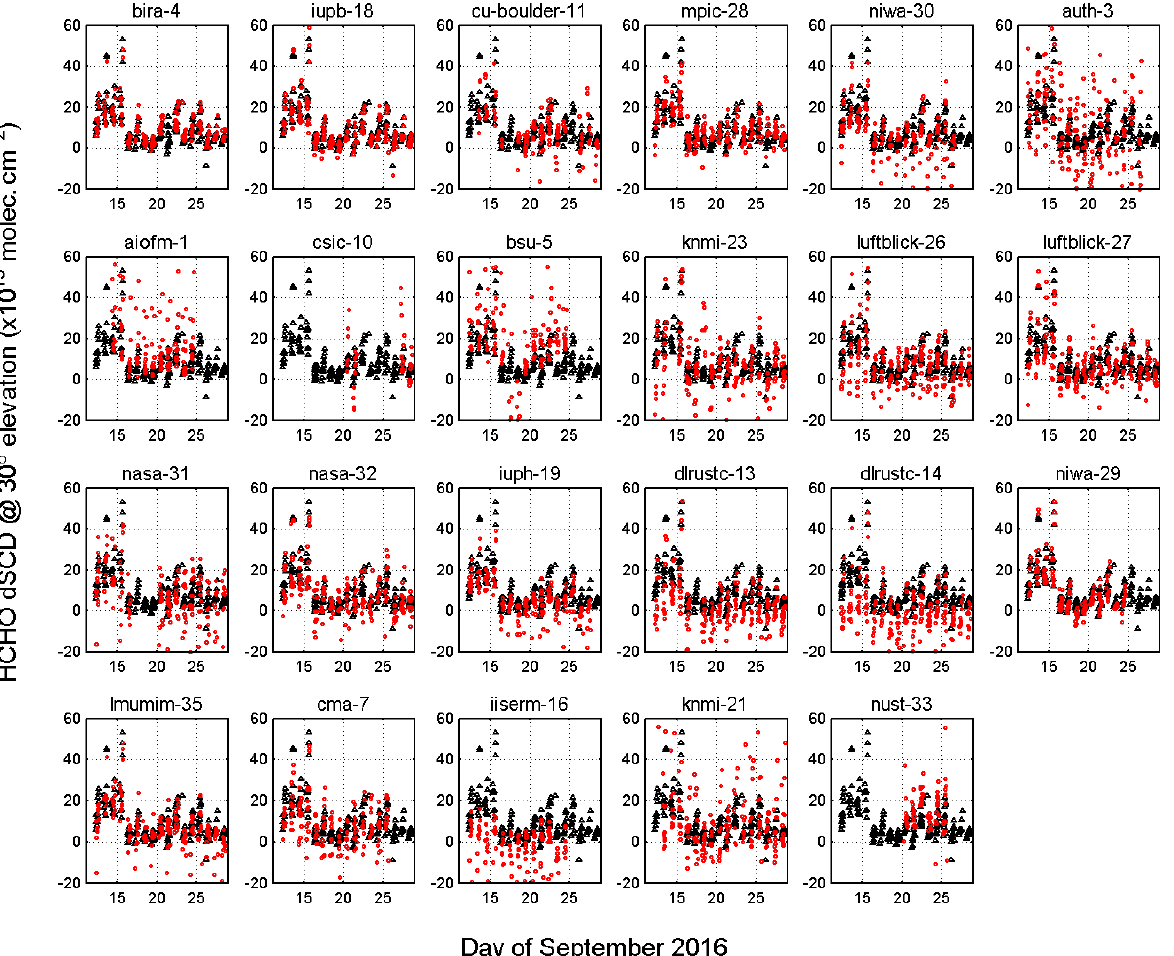
Figure 9. Comparison of HCHO dSCDs retrieved by each group at 30 ◦ elevation (red dots), and median values (black triangles). Only the four data sets (bira-4, iupb-18, mpic-28 and niwa-29) showing consistent values and a comparatively low noise level were selected for the calculation of the HCHO